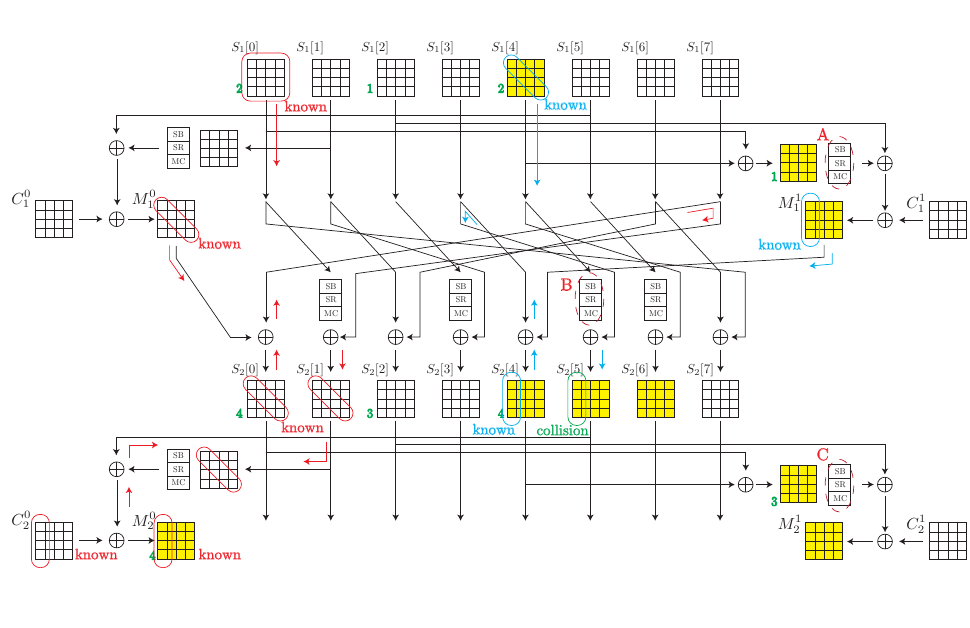
Figure 4: Meet-in-the-middle